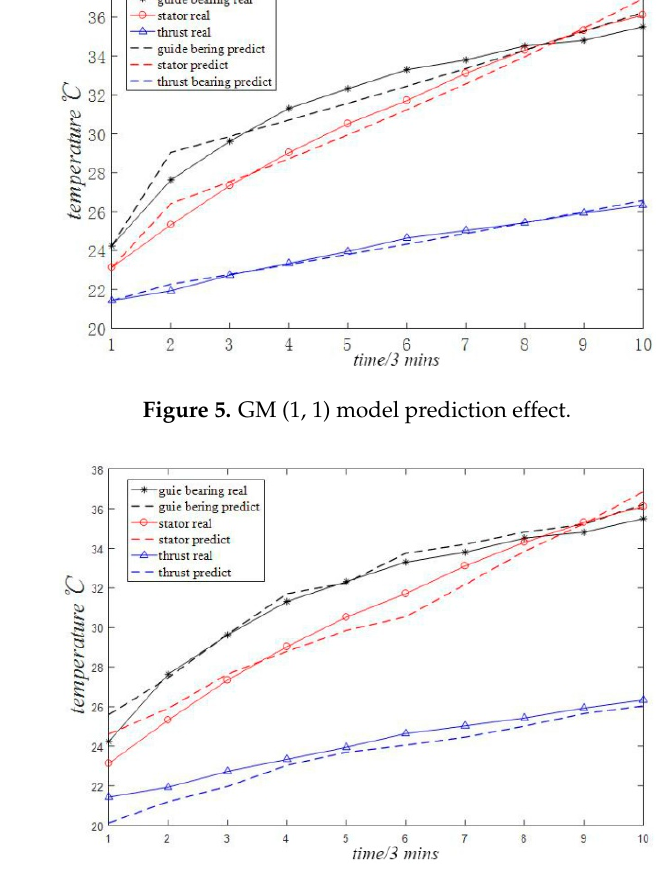
Figure 6. Prediction effect of BP neural network model.